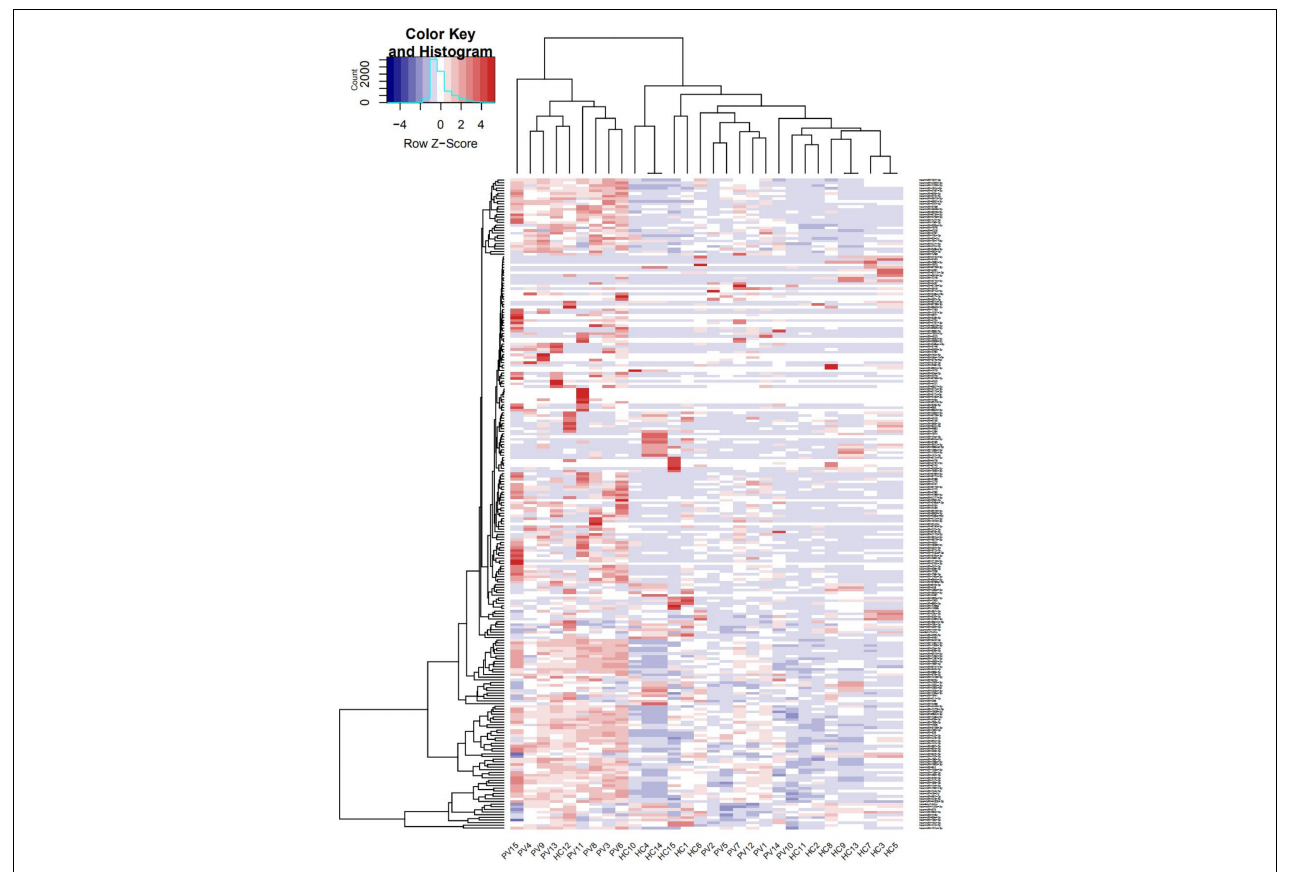
FIGURE 3 | Characteristics of miRNA levels between different groups. Heat map showing the levels of miRNAs ( P < 0.05) in different groups. Colors from blue to red stand for z-score got through the dimensionality reduction of FPKM value and reveal decreasing miRNA levels in each group.